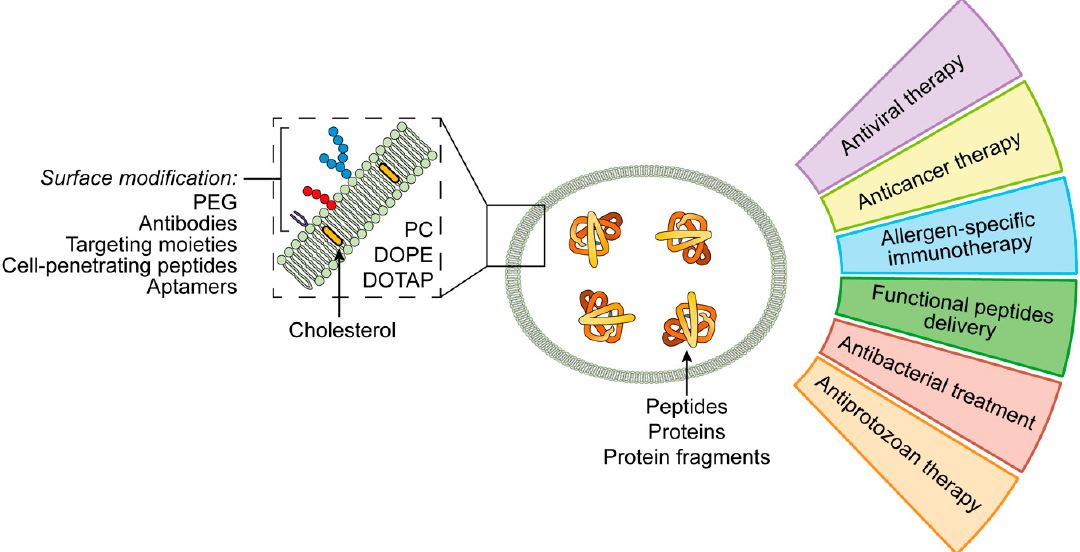
Figure 2. Applications of liposomal peptide and protein nanoformulations.